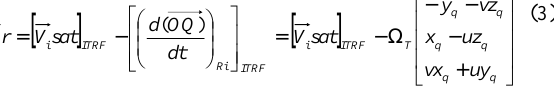
Figure 1. Atmospheric refraction between two layers